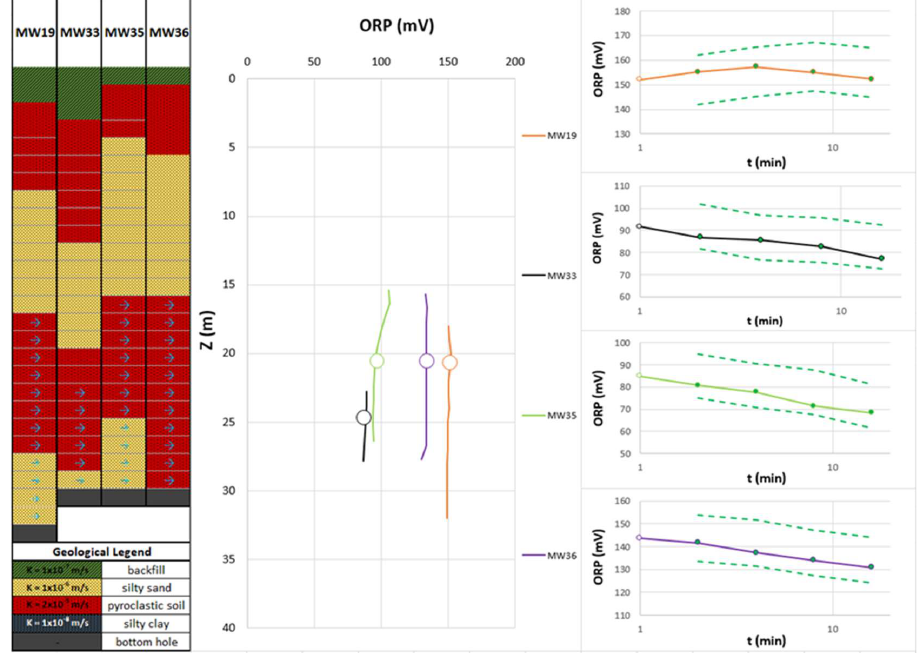
Figure 11. Layout of coupled log-purging (z-t) ORP results for low-heterogeneity well types (MW19, MW33, MW35 and MW36).